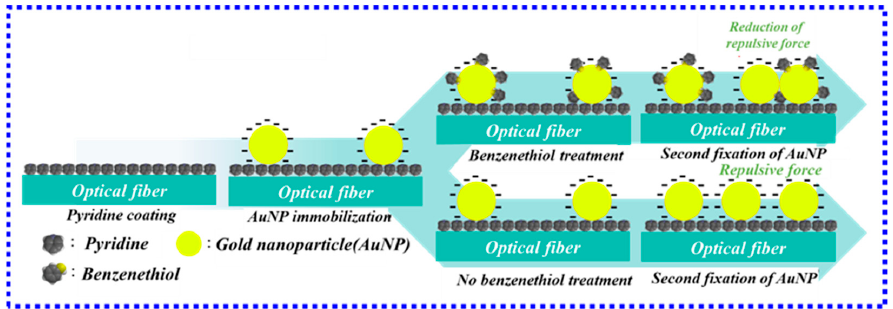
Figure 7. Schematic diagram of the fabrication process of fiber-optic LSPR sensors based on mono- mer (without benzenethiol treatment) and dimer (with benzenethiol treatment) [67]. Copyright 2023, Elsevier.